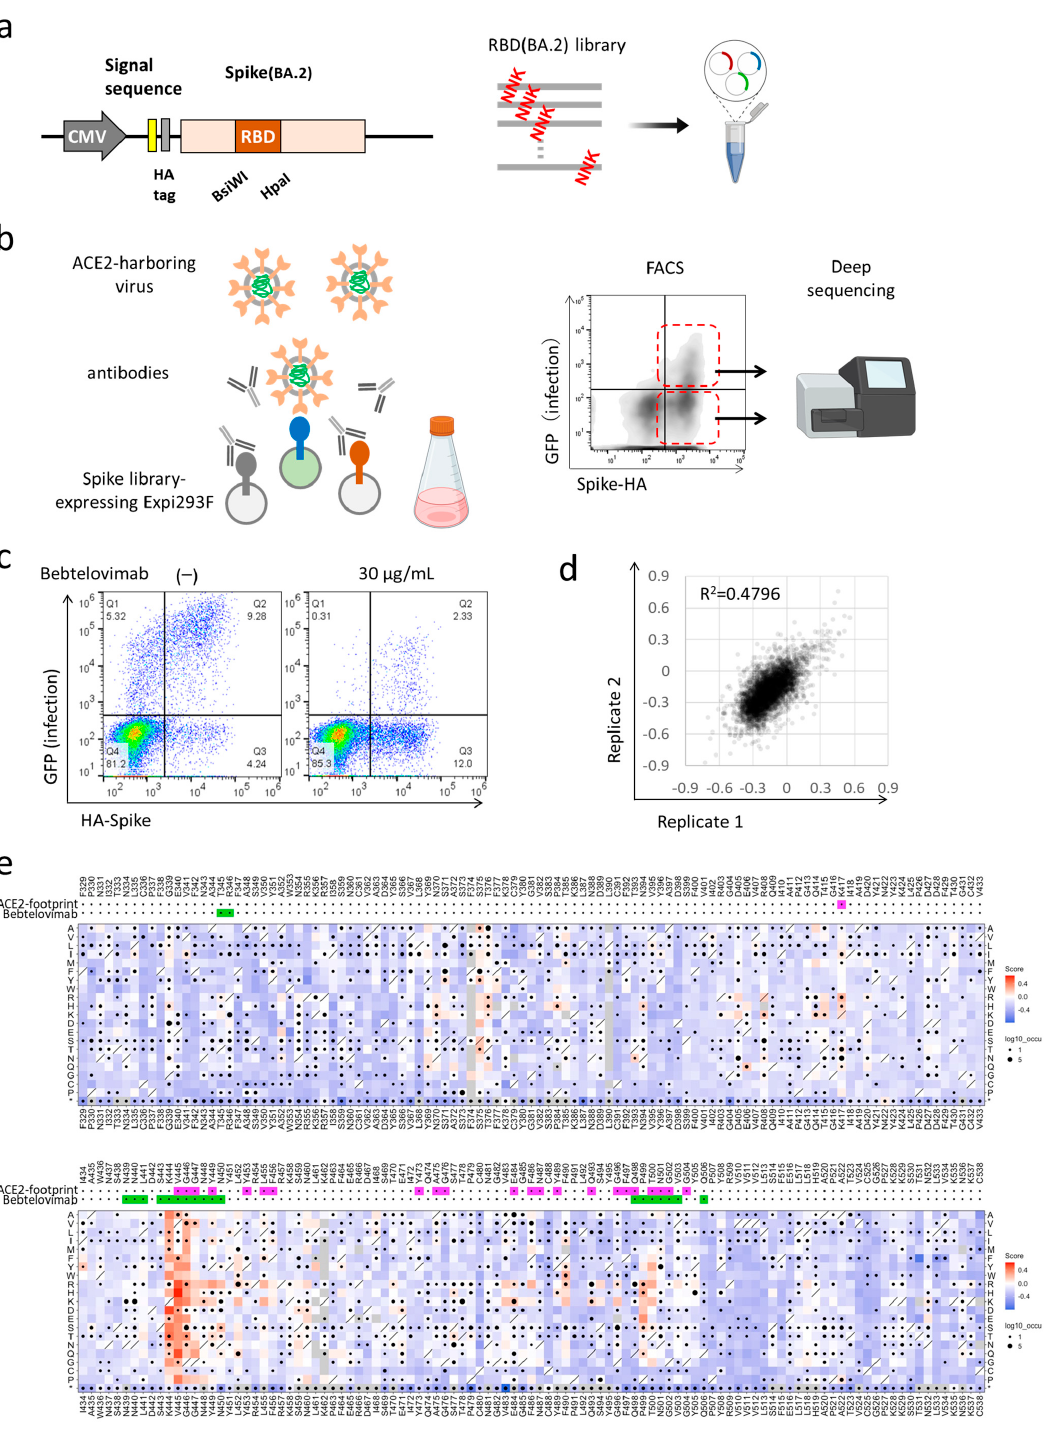
Figure 1. Deep mutational scanning identified single-residue mutation to induce escape from bebtelovimab. ( a ) A design of the deep mutational scanning (DMS) library for the